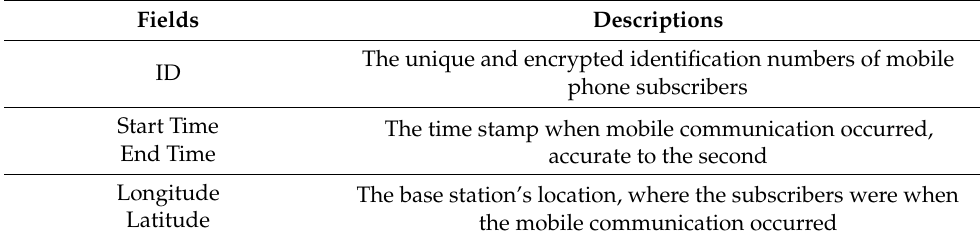
Table 1. Mobile communication data for Xining